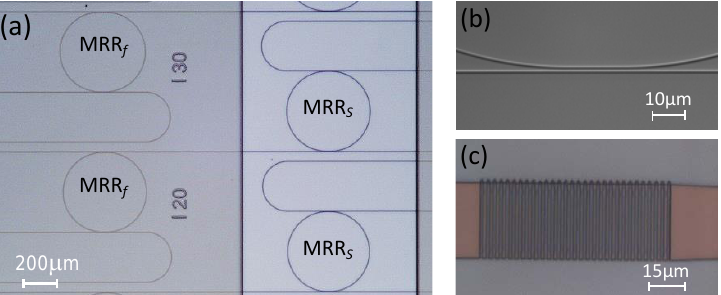
Figure 2. Optical microscope images of the fabricated sensors in SiN material: ( a ) CMRRs covered with a BCB passivation layer and opened on the sensor elements. ( b ) The coupling region between the bus waveguide and the MRR waveguide with a straight section length of 20 µm. ( c ) The tapered grating coupler with period of 1.2 µm used for coupling of the light into the sensor